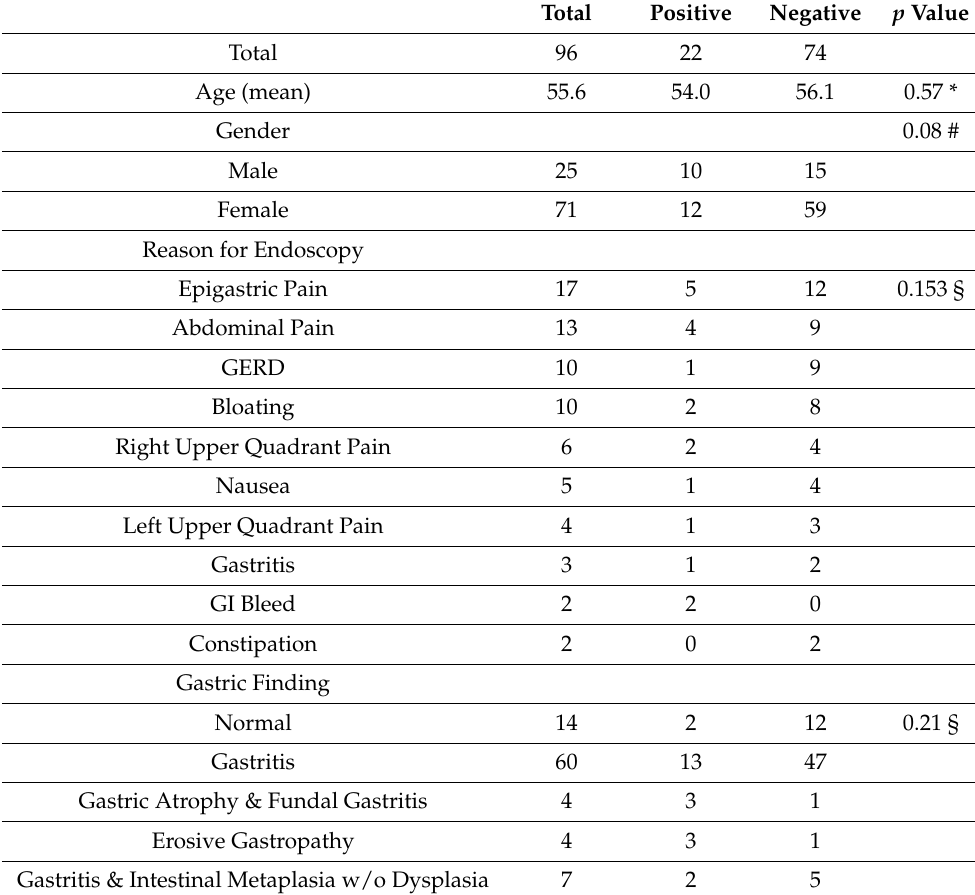
Table 2. Comparing demographic and clinical characteristics by positive or negative